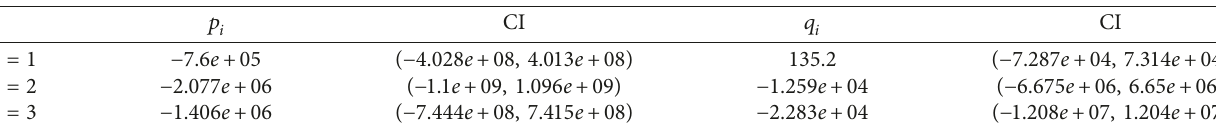
Table 21: R − 1 vs.